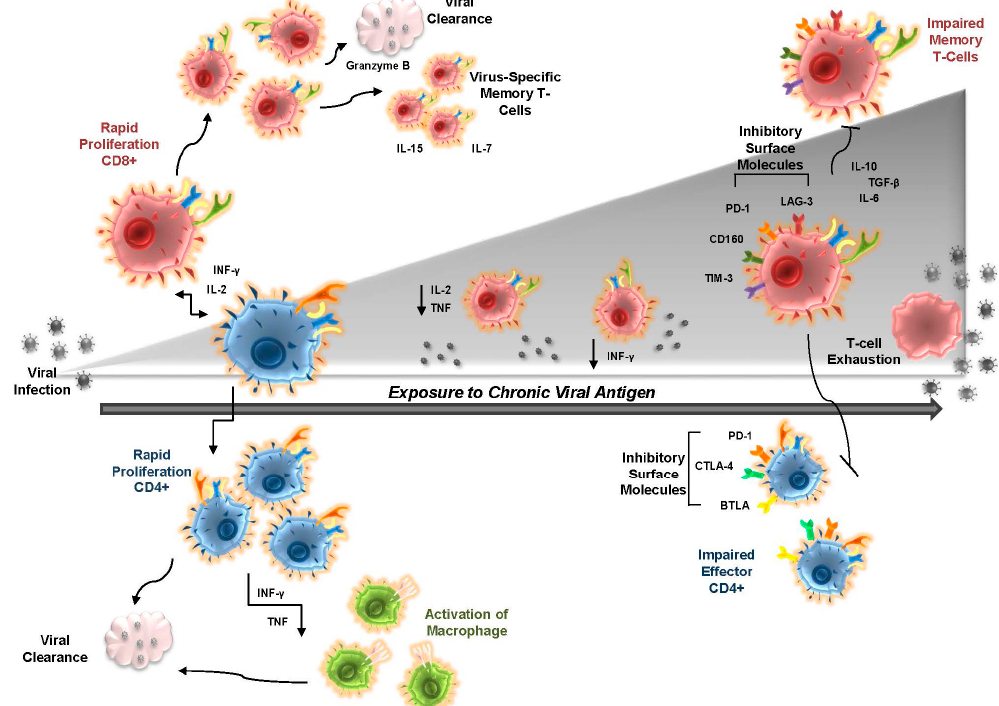
Figure 3. A depiction of T-cell exhaustion during chronic viral antigen exposure. Initial viral encounter leads to rapid activation of host adaptive immunity. A robust CD8+ (red cells) and CD4+ T-cell (blue cells) response occurs, leading to activation (arrows) of immune cytokines (IFN- γ , IL-2, and TNF), proliferation of host immune effector cells (CD4+ and CD8+ T cells, and the activation of macrophages (green cells), natural killer cells, etc.), generation of virus-specific memory (responsive to IL-7 and IL-15), and clearance of the invading viral pathogen (increases in perforin and granzymes, for example). Long-term exposure to virus or viral antigen leads to a step-wise decrease in effector cytokines and, over time, the appearance of T cells displaying hallmarks of exhaustion. This includes the up-regulation of inhibitory markers on the surface of the T cell (PD-1, LAG-3, CD160, TIM-3, CTLA-4, and BTLA), a differential loss (IL-2, TNF, and IFN- γ ) or gain (IL-10, IL-6, and TGF- β ) in cytokine expression, impaired CD8+ and CD4+ T-cell effector response, and impaired memory T cells that are no longer responsive to IL-7 or IL-15. Eventually, this can lead to T-cell senescence and/or apoptosis, rapid viral replication, and disease. (Abbreviations: BTLA, B- and T-Lymphocyte-Associated Protein; CD160, Natural Killer Cell Receptor BY55; CTLA-4, Cytotoxic T-Lymphocyte-Associated Protein 4; INF- γ , interferon-gamma; IL-2, interleukin-2; IL-6, interleukin-6; IL-7, interleukin-7; IL-10, interleukin-10; IL-15, interleukin-15; LAG-3, Lymphocyte Activating 3; PD-1, Programmed Cell Death 1; TGF- β , Transforming Growth Factor β ; TIM-3, T-Cell Immunoglobulin Mucin Family Member 3; and TNF, tumor necrosis factor). Arrows show the increase/decrease of cytokine release during antigen exposure and the directionality of the immune response.